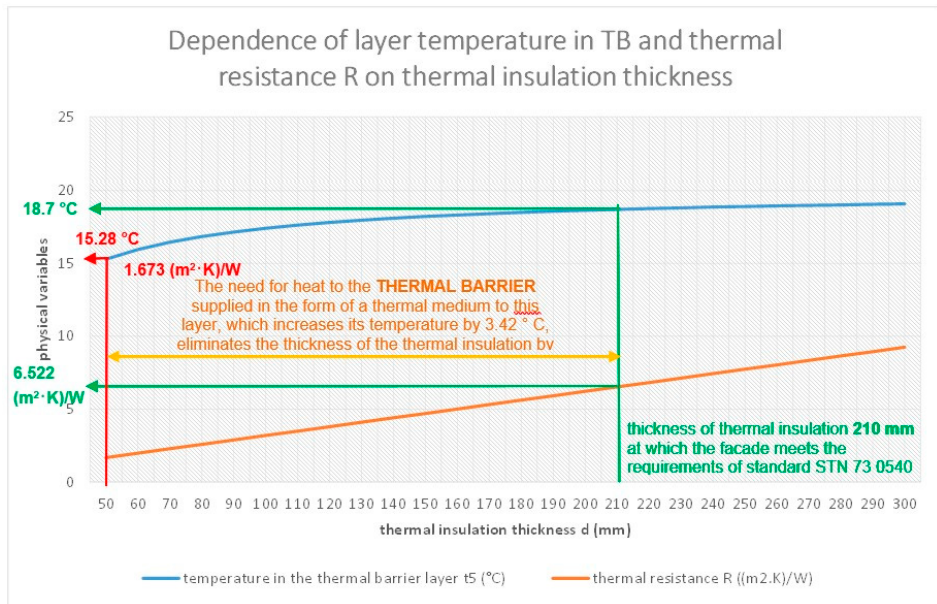
Figure 3. Dependence of layer temperature in TB and thermal resistance R ((m 2 ∙ K)/W) on thermal insulation thickness.